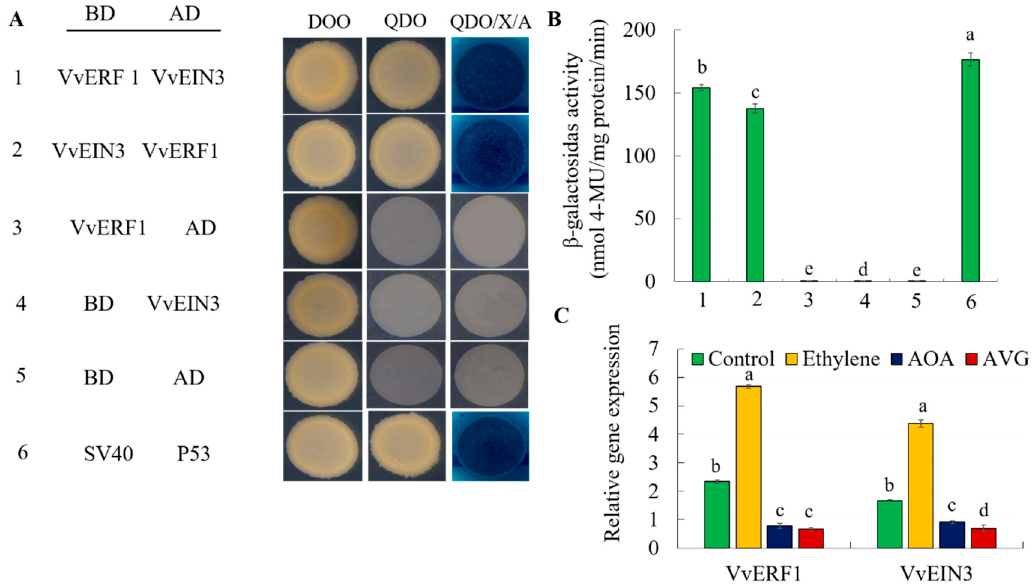
Figure 13. Yeast two-hybrid system for VvERF1 and VvEIN3. ( A ) VvERF1 fragments were ligated into the pGBKT7 vector (binding domain (BD)) and VvEIN3 into the pGADT7 vector (activation domain (AD)). DDO, SD medium lacking Trp/Leu; QDO, SD medium lacking Trp/Leu/His/Ade; X-a-gal, QDO medium containing x-a-gal and AbA. The SV40 and P53 genes were used as the positive control, and AD and BD vectors were as the negative control. Blue plaques indicate interaction between two proteins. ( B ) β -galactosidase activity was quantified from the sample in ( A ). ( C ) Inhibitors of ethylene biosynthesis like Aminoetoxyvinylglycine (AVG) and aminoxyacetic acid (AOA) were sprayed on the grape fruit surface respectively, and the expression levels of VvERF1 and VvEIN3 genes were measured after 3 days in grape fruits. Values are means ± SD of three biological replicates. Different letters indicated a statistical difference at p < 0.05 as determined by Student’s test.